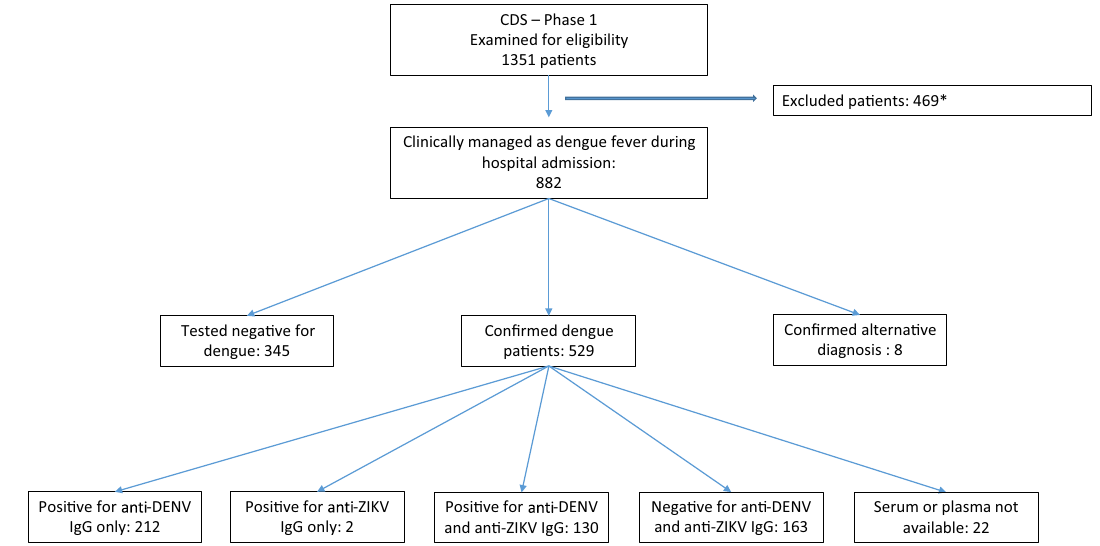
Figure 1. Flow chart showing patient recruitment to CDS and the numbers that tested positive for anti-DENV and ZIKV IgG. *Patients not meeting inclusion criteria of CDS (e.g., not presenting within the first three days of